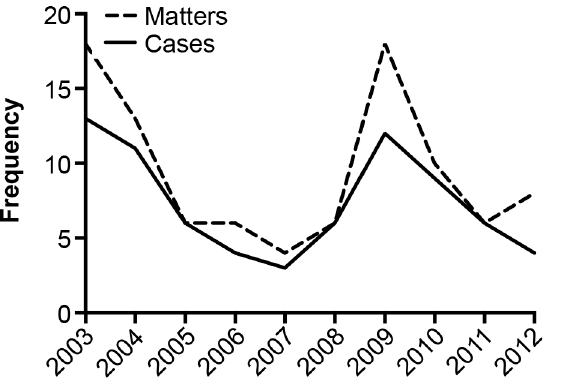
Fig 2. Off-label promotion rulings in the UK 2003 – 2012: Cases and matters in